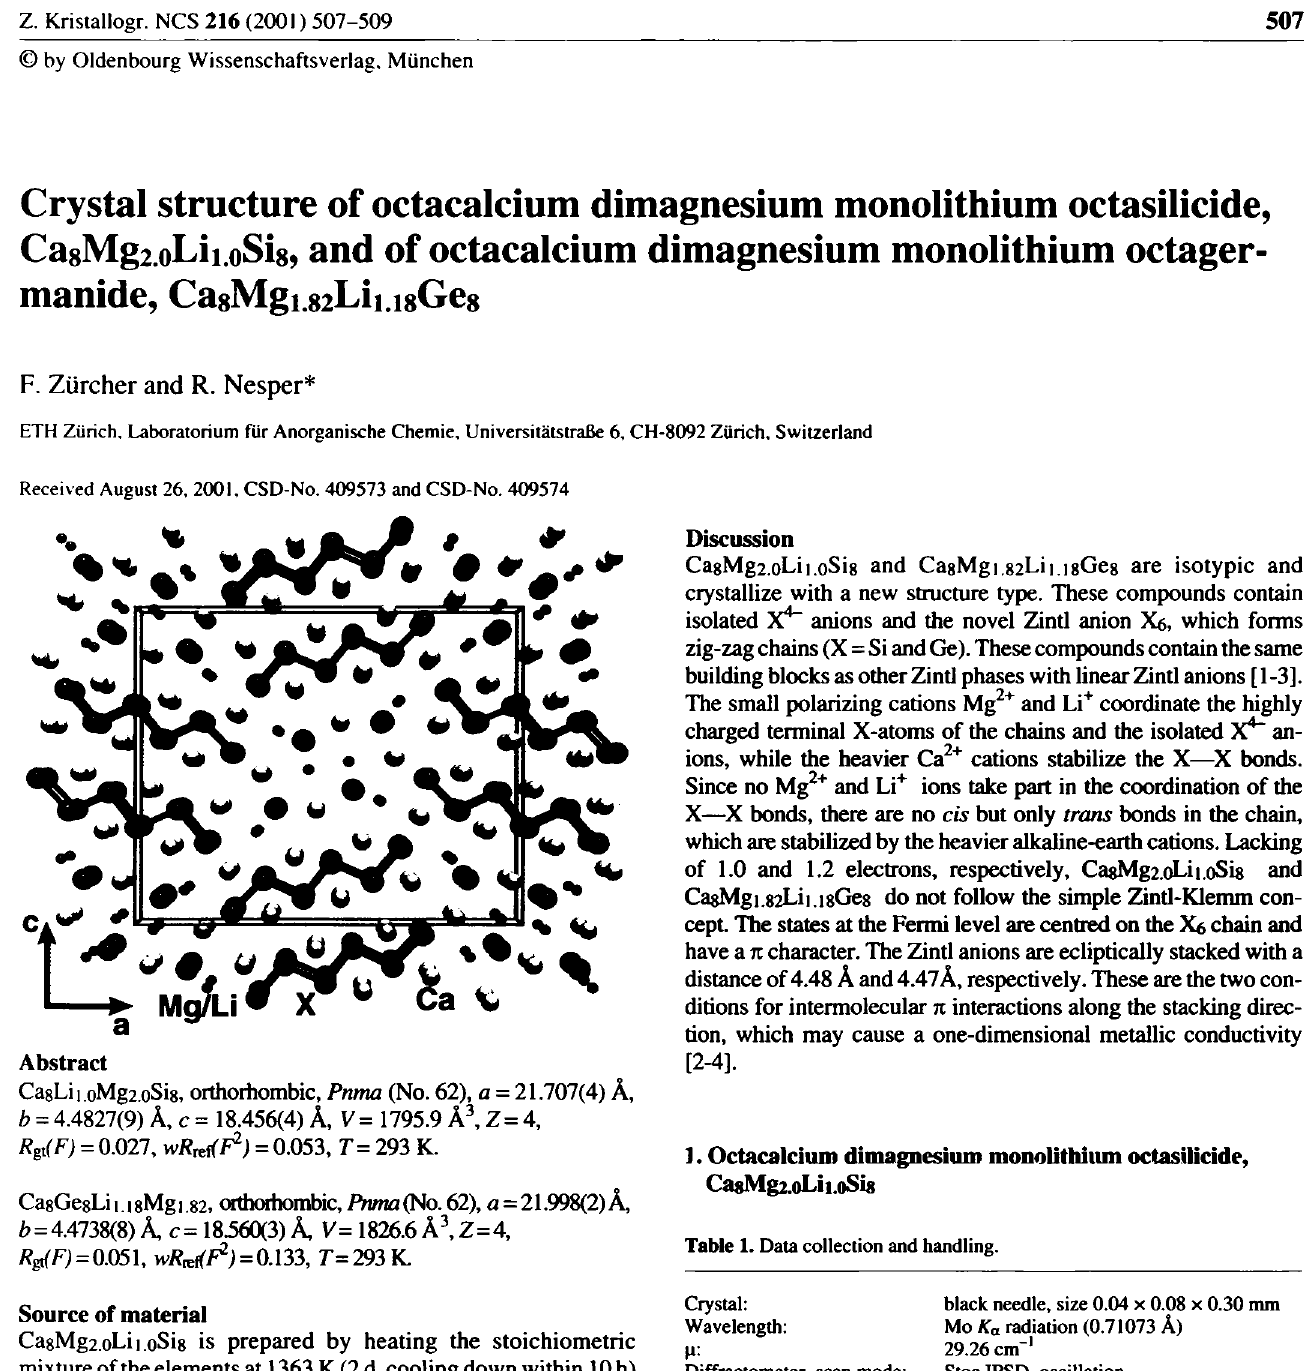
Table 1. Data collection and